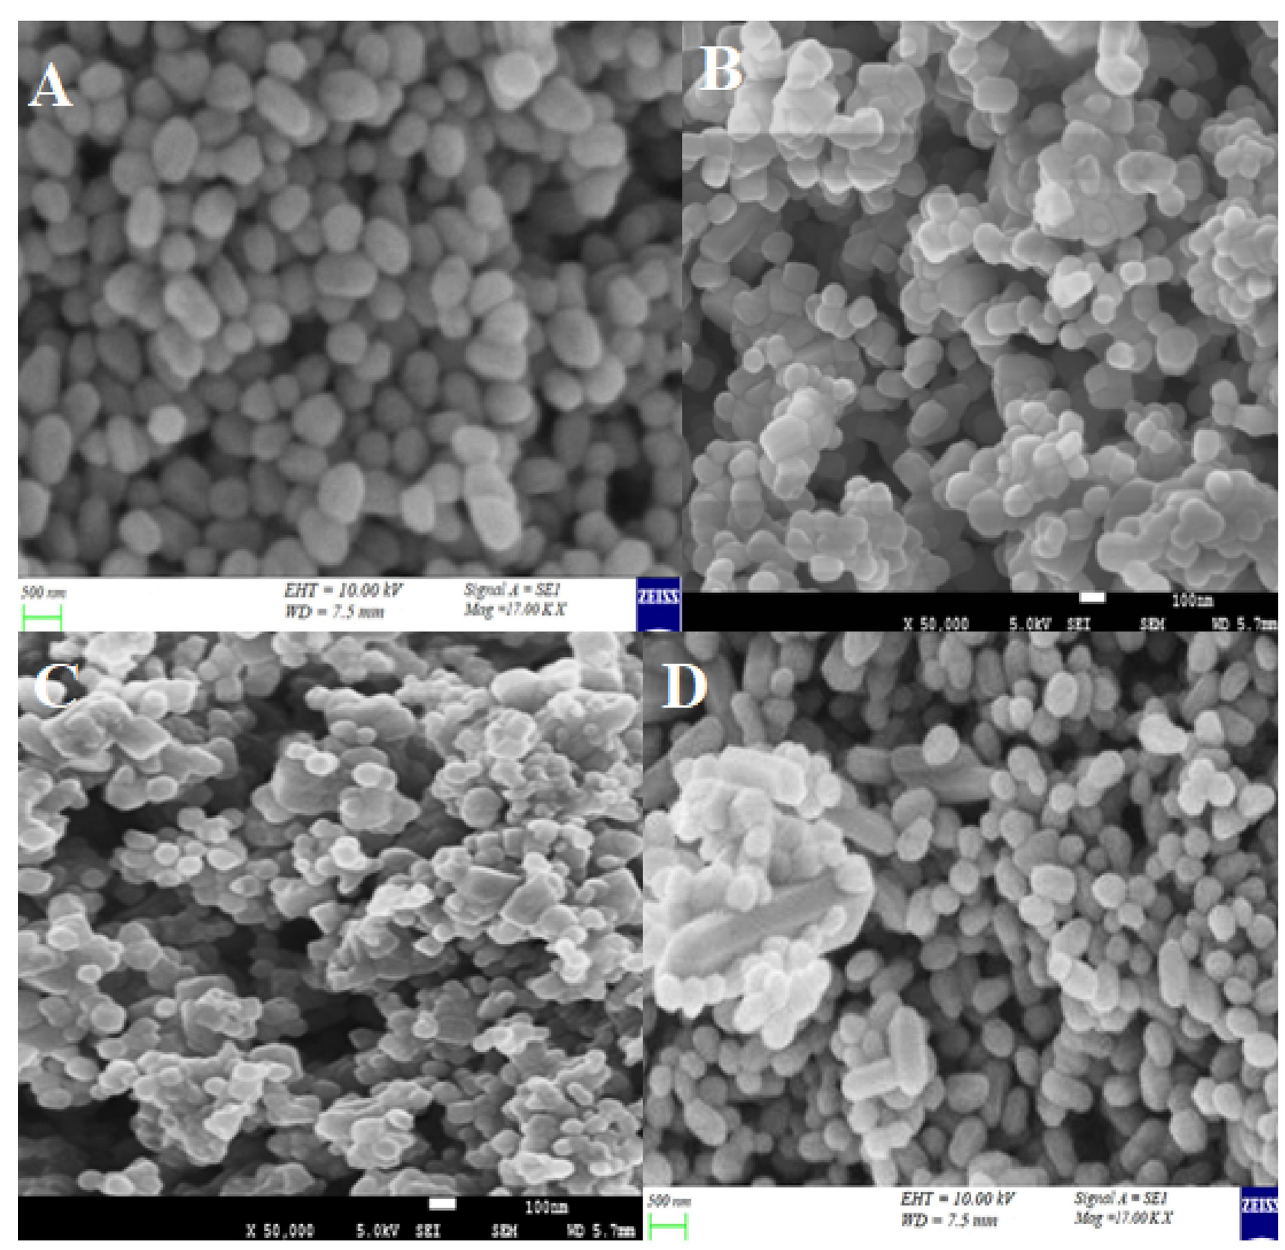
Fig 4. SEM images of conjugated NPs with Stretomycin (A) AgNPs-Stp (B) ZnO NPs-Stp (C) CuO NPs-Stp (D) FeO NPs-Stp.